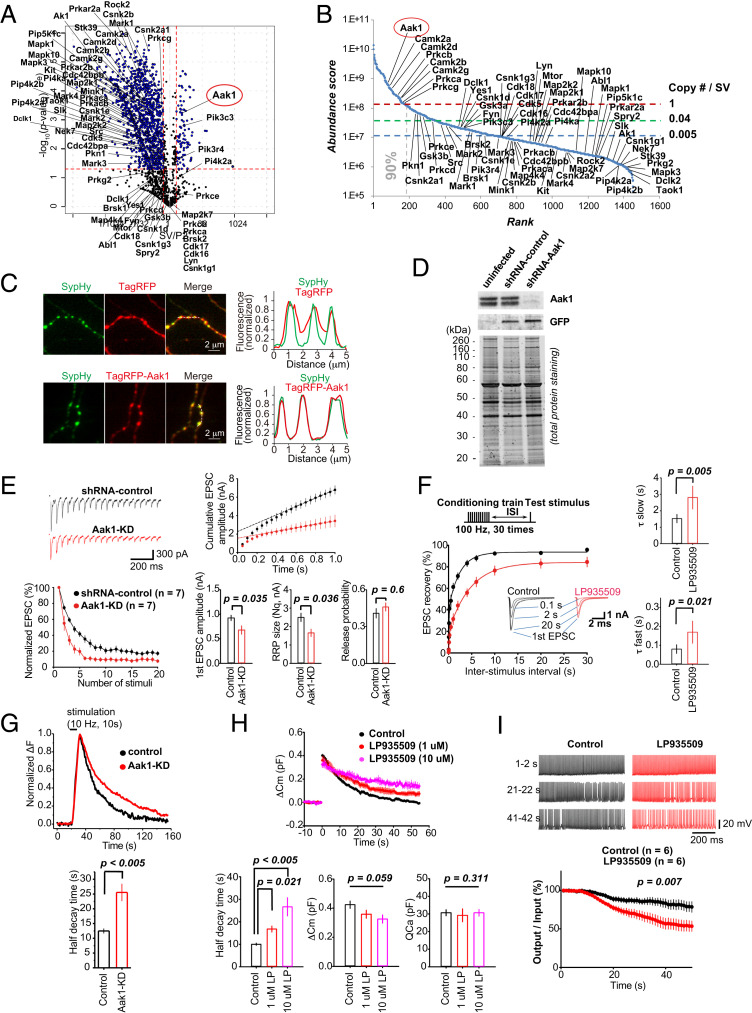
Aak1 is an SV-attached protein kinase essential for high-frequency neurotransmission. (A) SV/P2′ volcano plot of 69 kinases detected in the SV fraction by UD proteomics. Labels indicate names of genes encoding proteins. Aak1 (circled in red) is one of the few identified SV-residents. (B) SV kinases in the abundance curve. Aak1 is the most abundant of SV kinases. (C) Colocalization of exogenously expressed Aak1 and synaptophysin (SypHy) in cultured hippocampal neurons. (Upper) Control TagRFP (red) and SypHy (green) images and their line-scanned profiles (Right). (Lower) TagRFP-Aak1 (red) and SypHy (green) images and their line-scan profiles showing complete colocalization. (D) Lentivirus KD efficiency of Aak1 confirmed at DIV15 by Western blot analysis. Hippocampal cells were infected at DIV 11 to 12 with lentivirus coexpressing GFP and shRNA targeting Aak1. (E) Aak1-KD enhanced STD of EPSCs and reduced estimated readily releasable pool (RRP) size of SVs (Nq) evoked by a 20-Hz train of stimulation in Aak1-KD (red, n = 7) or shRNA control (black, n = 7) neurons. (F) LP935509 (1 μM) slowed both fast and slow components of recovery from STD (100 Hz) at the calyx of Held (red traces, n = 6, stimulation protocol indicated on the Top). EPSCs at different interstimulus intervals (ISIs) are shown in Insets. (G) Aak1-KD slowed endocytic SV fluorescence in response to stimulation in pHluorin analyses in hippocampal neurons. Aak1-KD (red), n = 16 neurons, 51 boutons; and control (black), n = 10 neurons, and 20 boutons. (H) LP935509 (1 or 10 μM) prolonged the SV endocytic half-time (P < 0.001, n = 6 at 1 μM and n = 4 at 10 μM: 4; one-way ANOVA: F(2,
13) = 16.81] without affecting exocytic [P = 0.059, F(2,
13) = 2.53] or presynaptic Ca2+ current magnitudes [P = 0.511, F(2,
13) = 0.15] in membrane capacitance measurements at the calyx of Held. (I) LP935509 (1 μM) impaired fidelity of glutamatergic neurotransmission at 100-Hz at the calyx of Held. (Top) Postsynaptic APs evoked by presynaptic APs in the presence (red) or absence (black) of LP935509 in presynaptic terminals. (Bottom) Percentages of postsynaptic APs elicited by presynaptic APs, controls (n = 6) and the Aak1 inhibitor (n = 6).